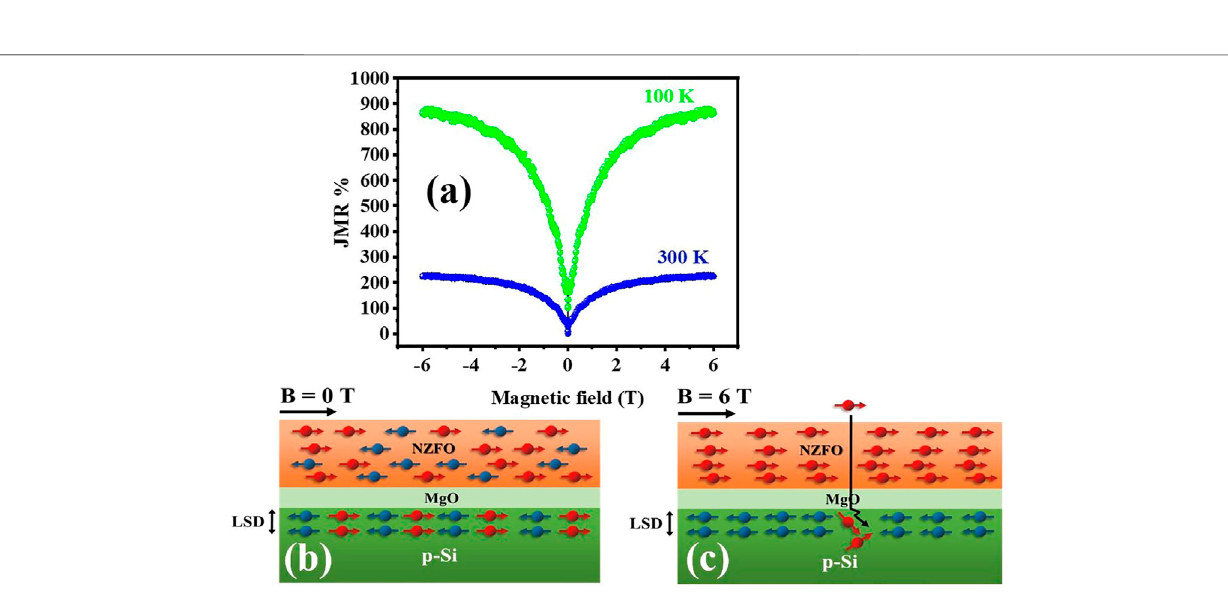
Frontiers in Materials |